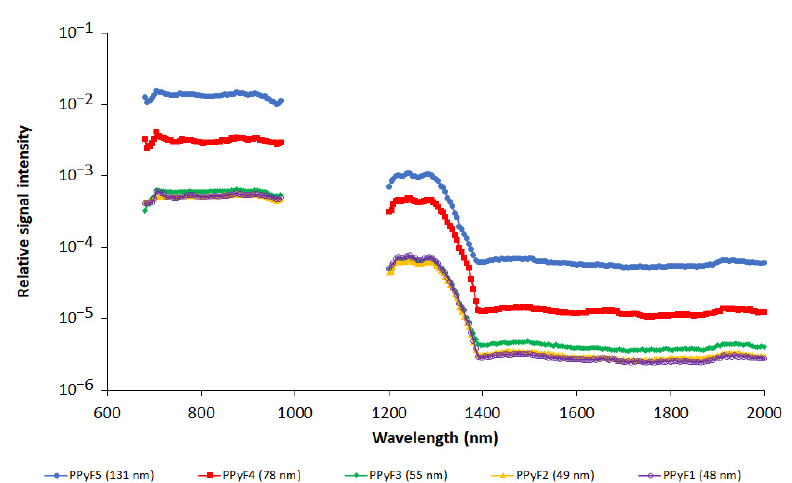
Figure 4. Photoacoustic spectra of polypyrrole nanoparticles prepared with FeCl 3 oxidant. Different pyrrole and oxidant ratios are presented at 680–970 nm and 1200–2000 nm ranges. Spectra are recalculated per one nanoparticle. Note logarithmic scale on y-axis. NP concentration was 3 mg/mL.